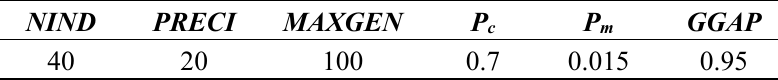
Table 6. The parameters of improved genetic